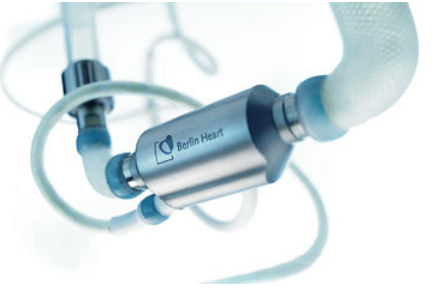
Figure 7 Incor  (cid:1)